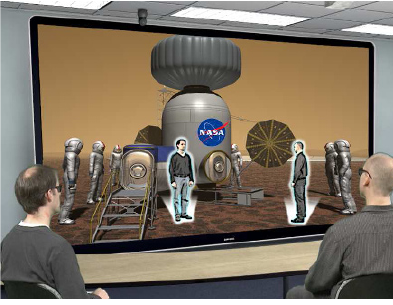
Figure 12. Blended immersive physical world and virtual world with holographic life-like